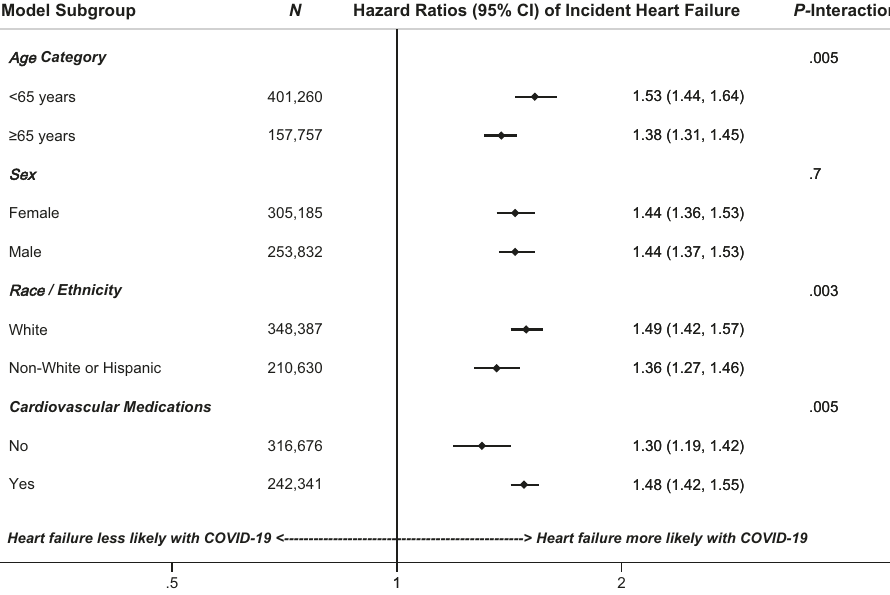
The data that support the fi ndings of this study may be requested from NCATS (covid.cd2h.org) but restrictions apply. Access to data requires N3C onboarding and following the regulatory and training requirements that all N3C users must abide by.